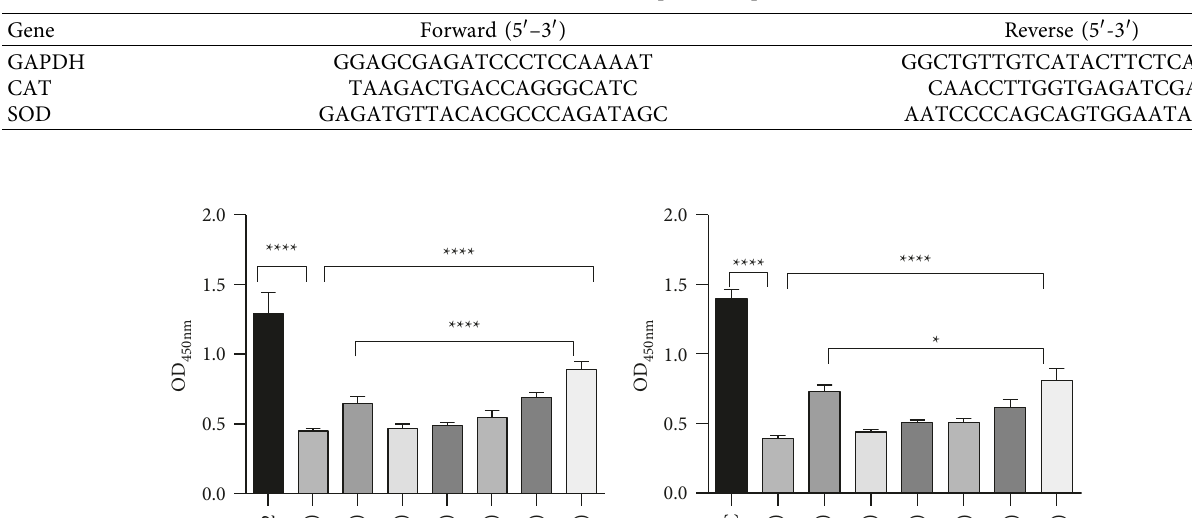
Table 1: Real-time PCR primer